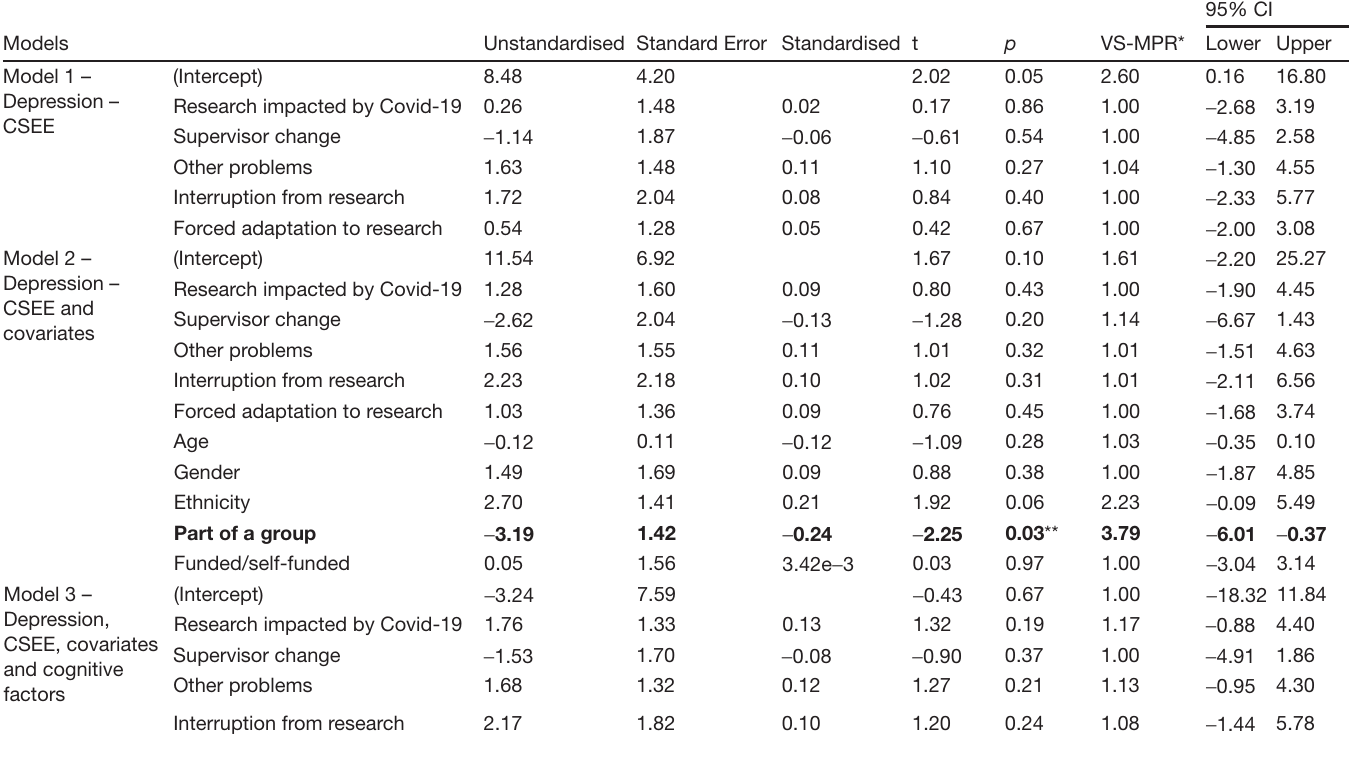
Supplementary Table 2. Coefficients for depression and anxiety models for specific events